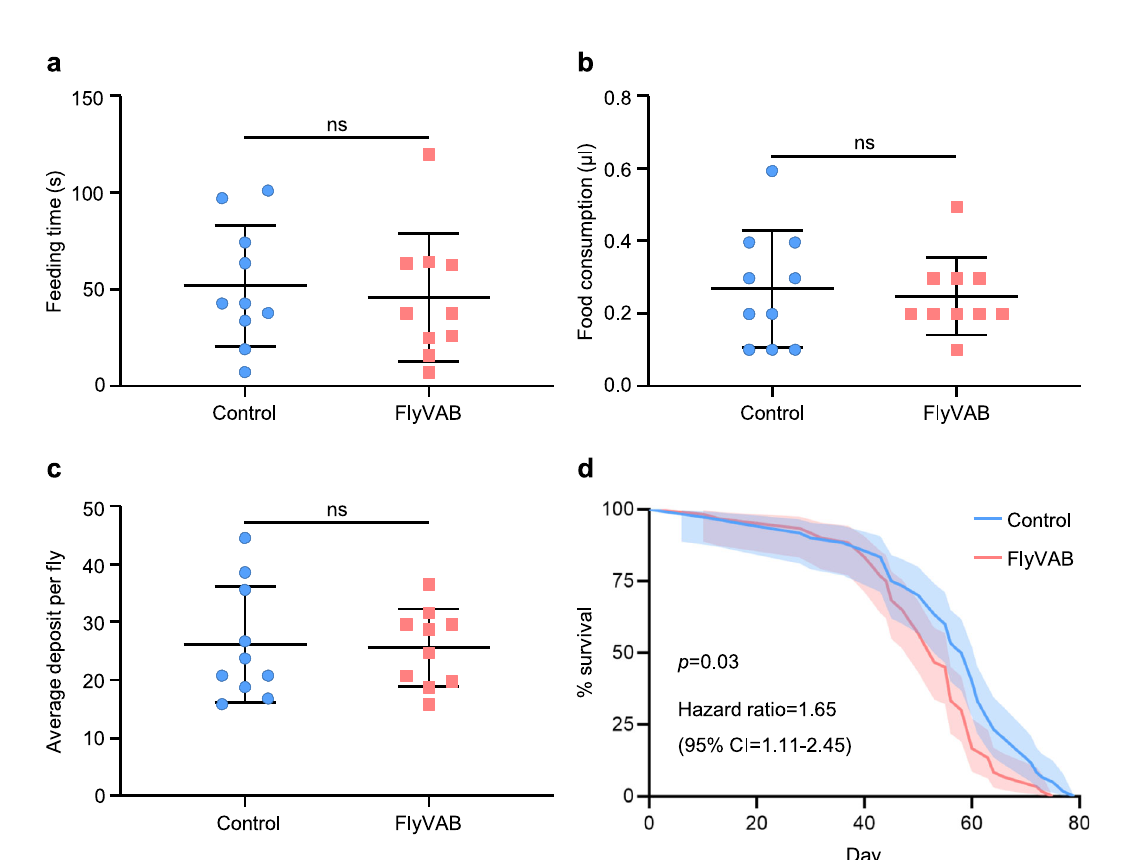
Fig. 2 Undetectable adverse physiological effects in fl ies subjected to FlyVAB. a , b MAFE assay to measure food ingestion after a single compression. The feeding time ( a ) and food consumption ( b ) were quanti fi ed in each fl y ( n = 10 per group). Results are shown as mean ± SD. c The defecation assay after a single compression. Thirty fl ies per group were fed with 5% sucrose containing a blue dye, then placed into 10 separated vials. The blue deposit was counted on each vial after 12 h. The average deposit per fl y was calculated for each vial. Results are shown as mean ± SD. d The survival curve after multiple compressions. A total of 97% fl ies were alive after being released after loading every 2 days from day 0 to day 14 ( n = 60 per group), p = 0.03 (HR = 1.65; 95% CI = 1.11 – 2.45). The Drosophila strain used for all the experiments was the Oregon R ( wild type ). ns, not signi fi cant. See the Methods section for all the experimental